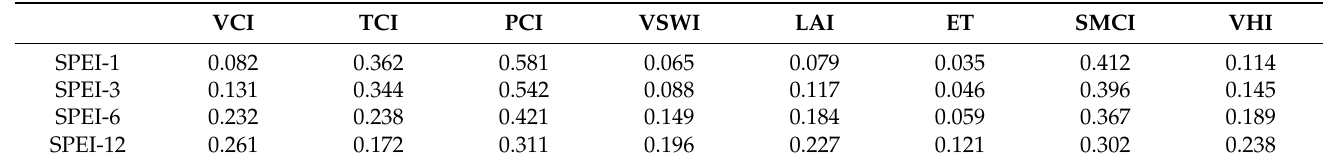
Table 4. Correlation coefficient (R 2 ) values of individual remotely sensed drought indices with different time scales of